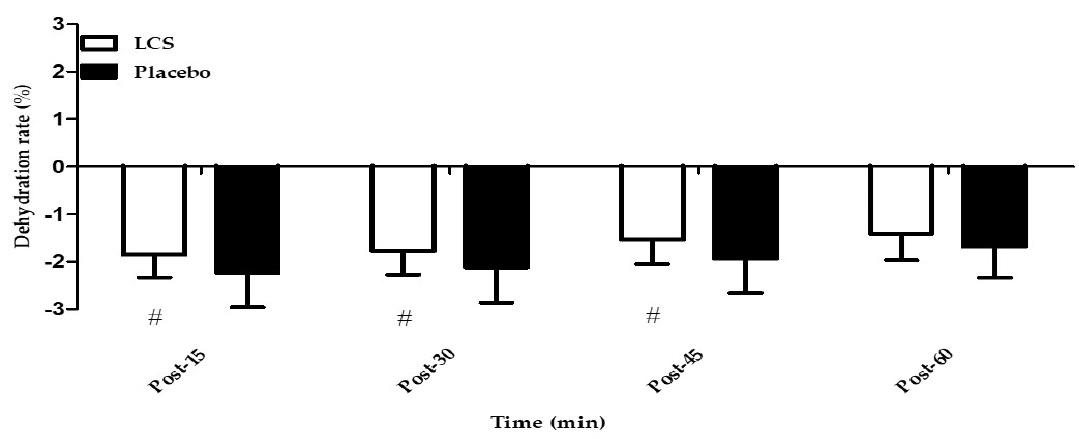
Figure 2. Changes in dehydration rate after exhaustive endurance exercise. The dehydration rate was calculated using difference ratios compared with baseline body weight at the indicated time points (45, 30, and 15 min) after exhaustive endurance exercise. #Significant ( p < 0.05) difference